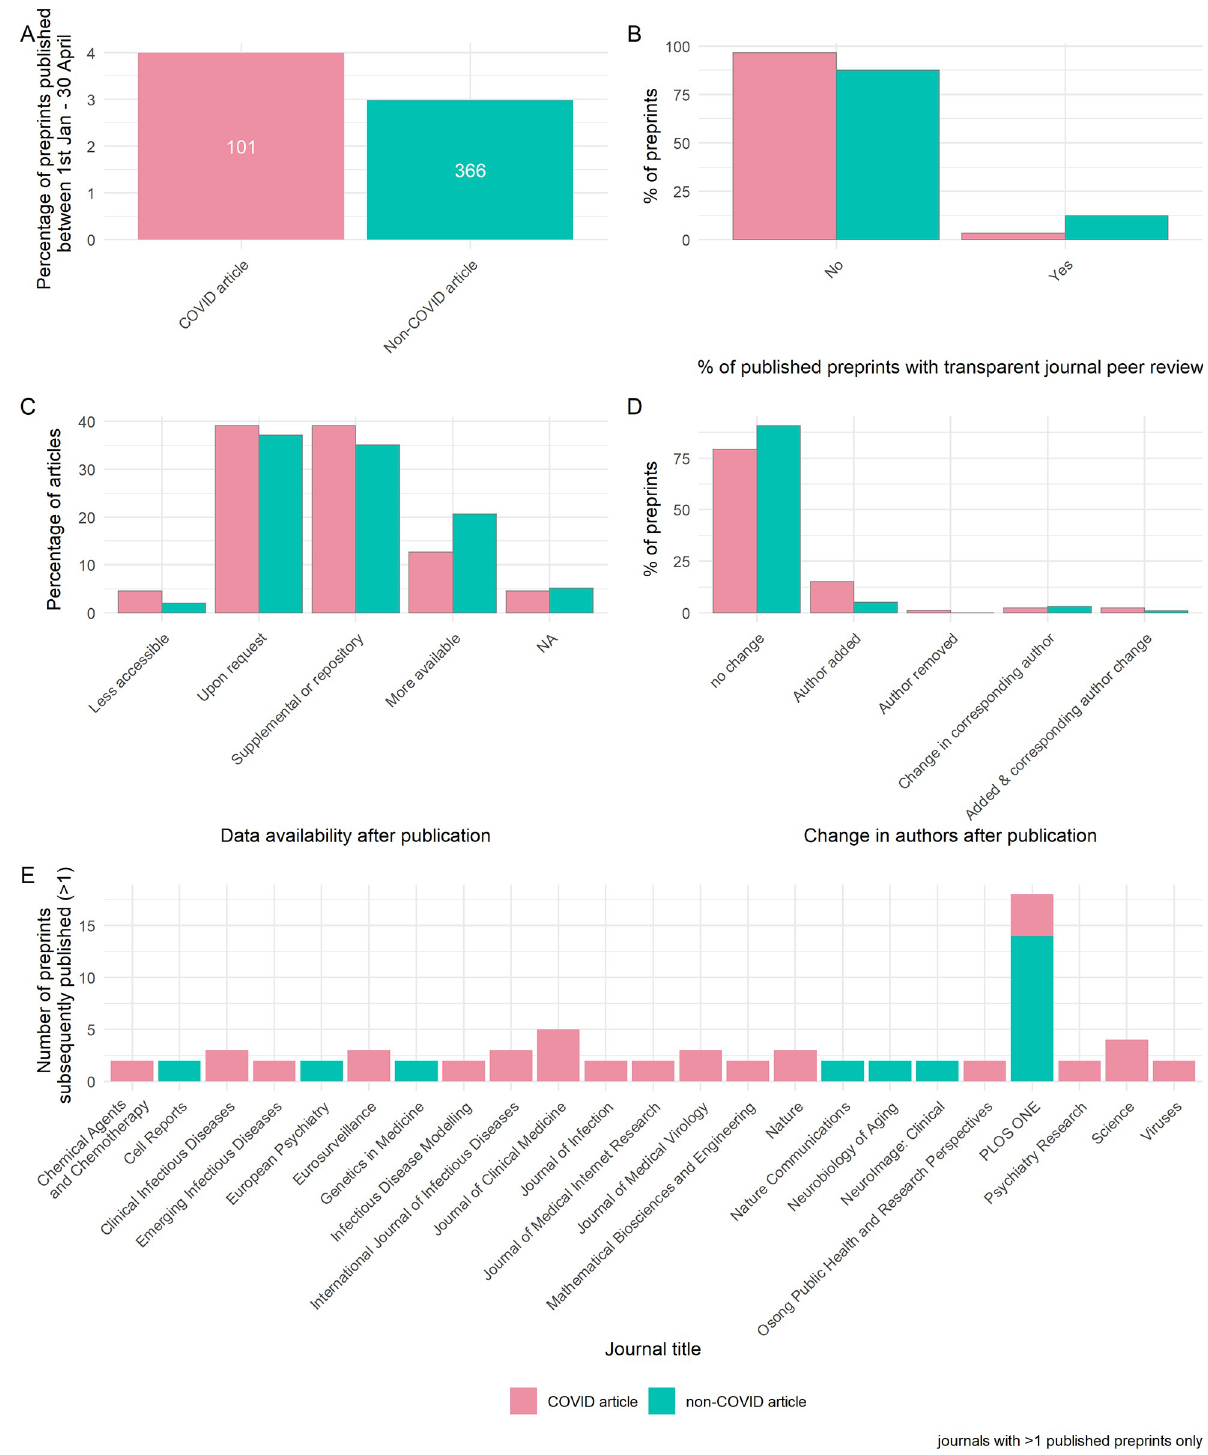
Fig 1. Publishing and peer review of preprints during the COVID-19 pandemic. (A) Percentage of COVID-19 and non-COVID-19 preprints published by April 30, 2020. Labels denote absolute number. (B) Percentage of published preprints associated with transparent peer review (the publication of review reports with the journal version of the article). (C) Data availability after publication. (D) Change in authorship after publication. (E) Journals that are publishing preprints. Panel A describes all available data ( n = 14,812 preprints), while panels B–E describe sample of preprints analysed in detail ( n = 184). The data underlying this figure may be found at https://github.com/preprinting-a-pandemic/preprint_changes and https://zenodo.org/record/5594903#.YXUv9_nTUuU. C AU : AbbreviationlistshavebeencompiledforthoseusedthroughoutFigs 1 to 3 : Pleaseverifythatallentriesarecorrect : OVID-19, Coronavirus Disease